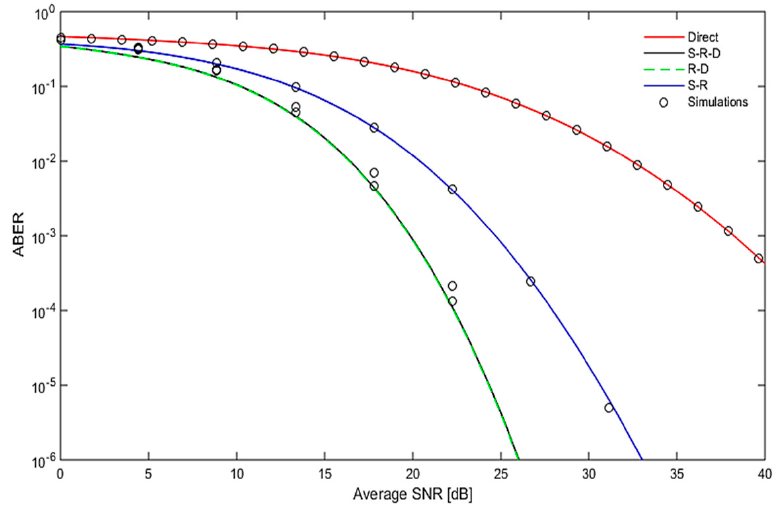
Figure 5. ABER vs. SNR of FSO over L-N channel for moderate turbulence with distance 400–600 m, the number of relays = 3, and w z = 2m.